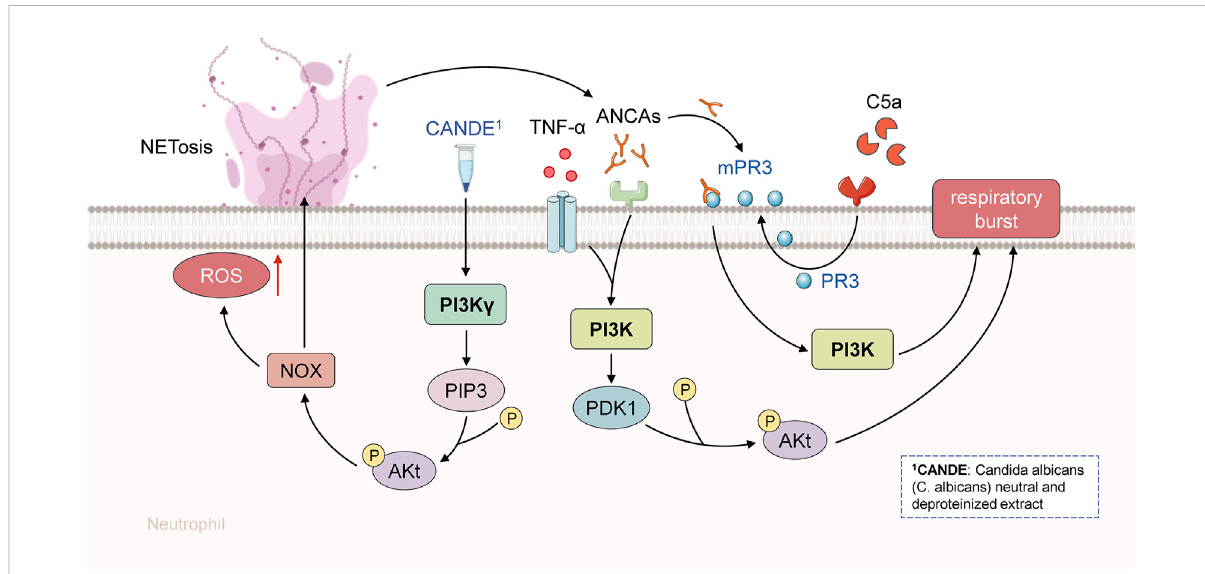
FIGURE 3 PI3K signaling pathway in the pathogenesis of AAV. ANCA and TNF- α activated human polymorphonuclear neutrophils. PI3K was activated during TNF- α initiation. PI3K and Akt are involved in the control of phagocyte respiratory burst, while PI3K can control ANCA-induced respiratory burst. Akt can be activated and phosphorylated by the product of PI3K or p38MAPK substrate